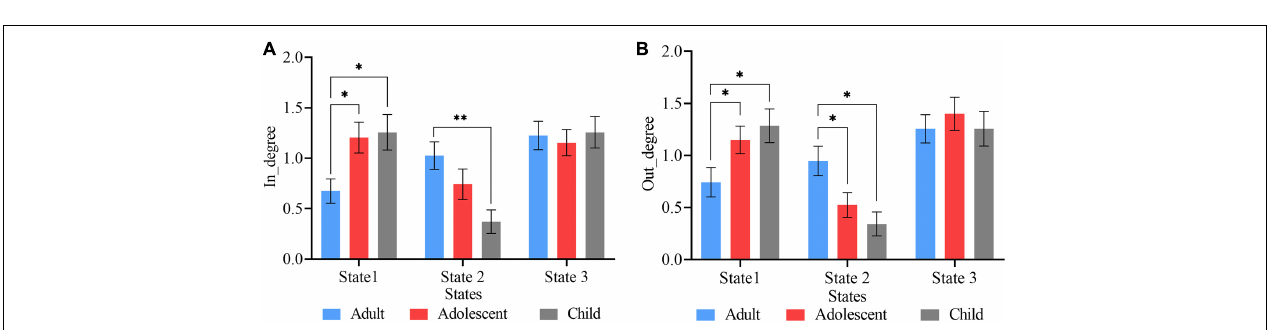
FIGURE 5 | The average transition matrix and transition probabilities of each age group. (A–C) Represent the average matrix for adult, adolescent, and child ADHD patients, respectively.